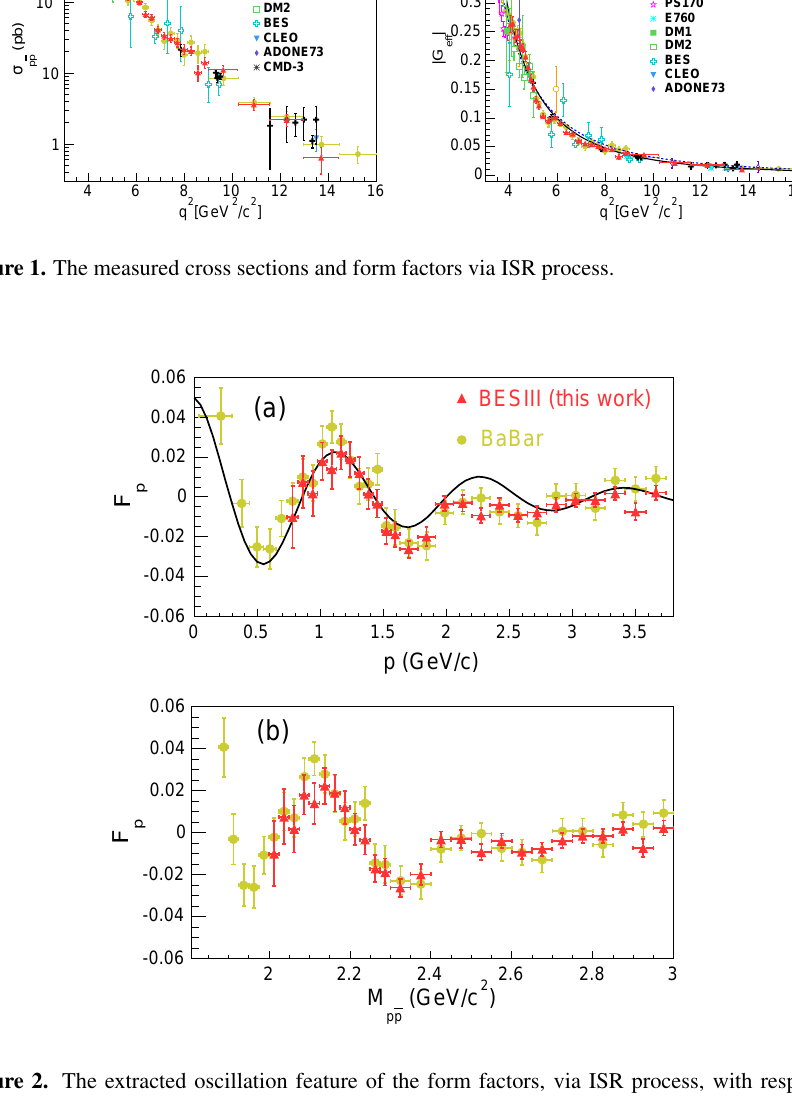
Figure 2. The extracted oscillation feature of the form factors, via ISR process, with respect to (a) momentum and (b) invariant